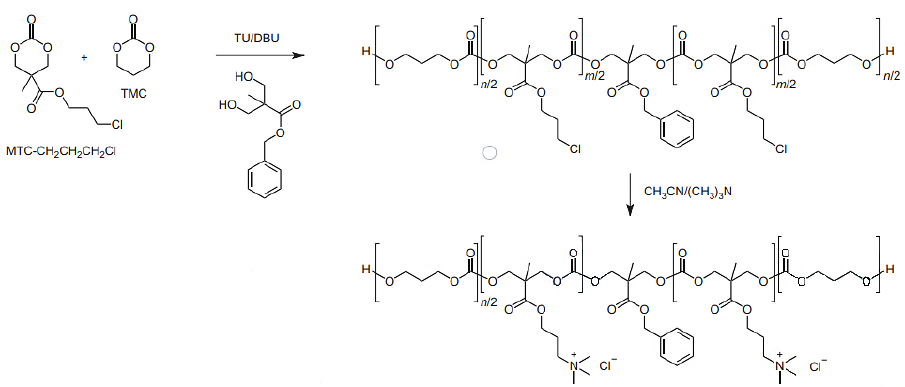
Figure 14. Synthesis of amphiphilic polycarbonates – based on [329].